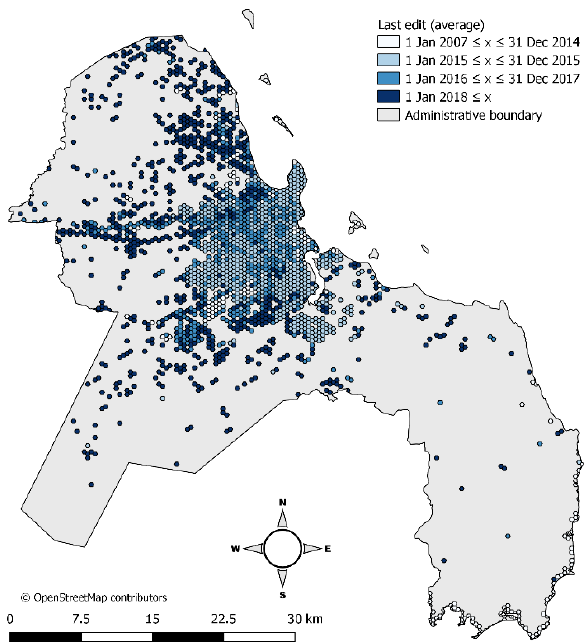
Figure 6. Dar es Salaam grid classified according to the average date of last edit of OSM nodes (map data © OpenStreetMap